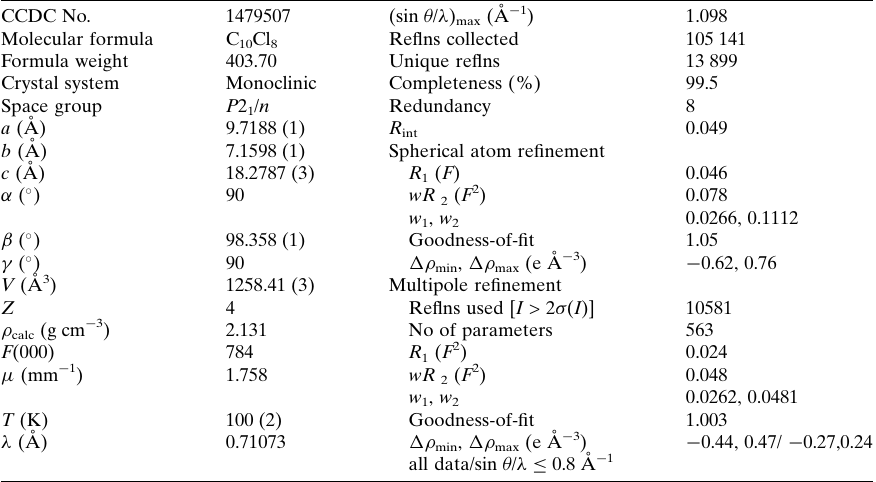
Table 1 Crystallographic parameters. CCDC